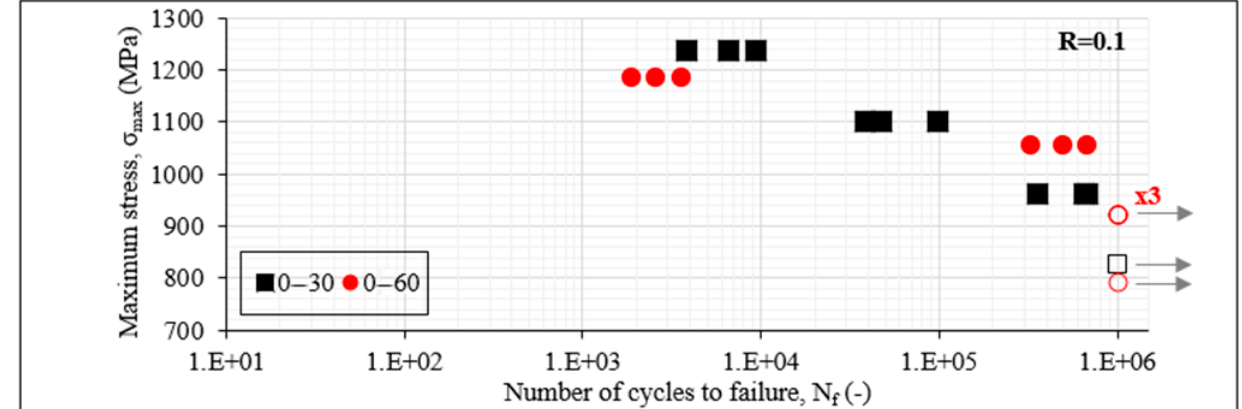
Figure 4. S-N f data of [0°/30°] 2s and [0°/60°] 2s laminates for R = 0.1.